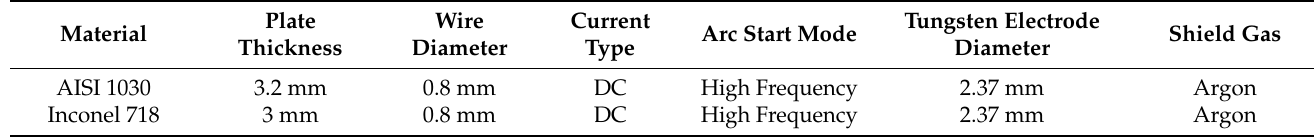
Table 1. Welding parameters used for testing with plain carbon